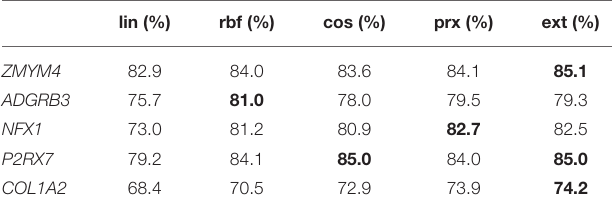
Performance test on binary classification of mutant vs. wild-type in TCGA-GBM mutation count data. The rows are different genes, the mutation statuses of which were imputed using m r samples in each mutant and wild-type class. The entries show the average of optimal5-foldcross-validationmeanaccuracyscoresoffiveruns.Theboldvaluesindicate the highest accuracy score in each row.